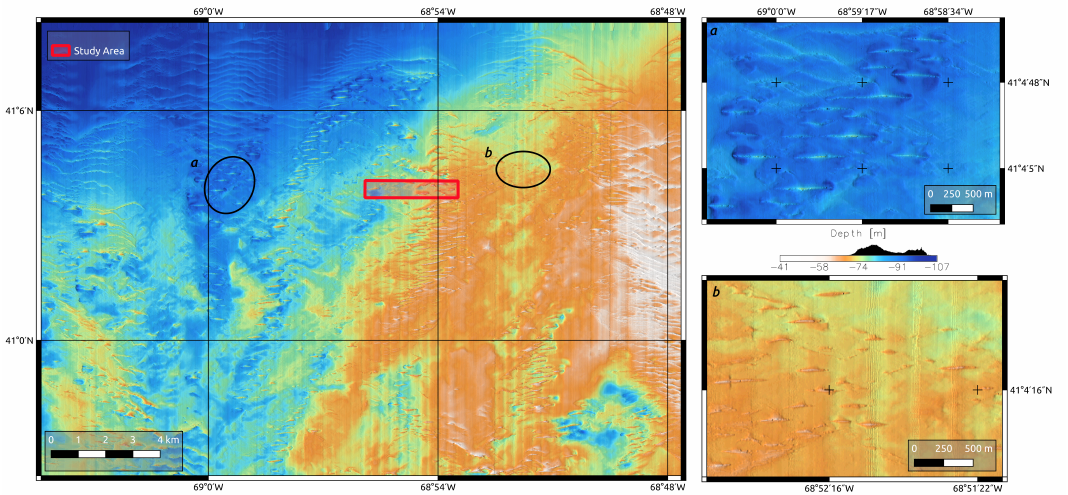
Figure 38. Portion of the USGS bathymetry collected in 1998 [23]. The isolated bedforms object of this study are a representative feature of the Great South Channel seabed. The zoomed areas ( a , b ) show in detail two, of many, areas where it is possible to find isolated